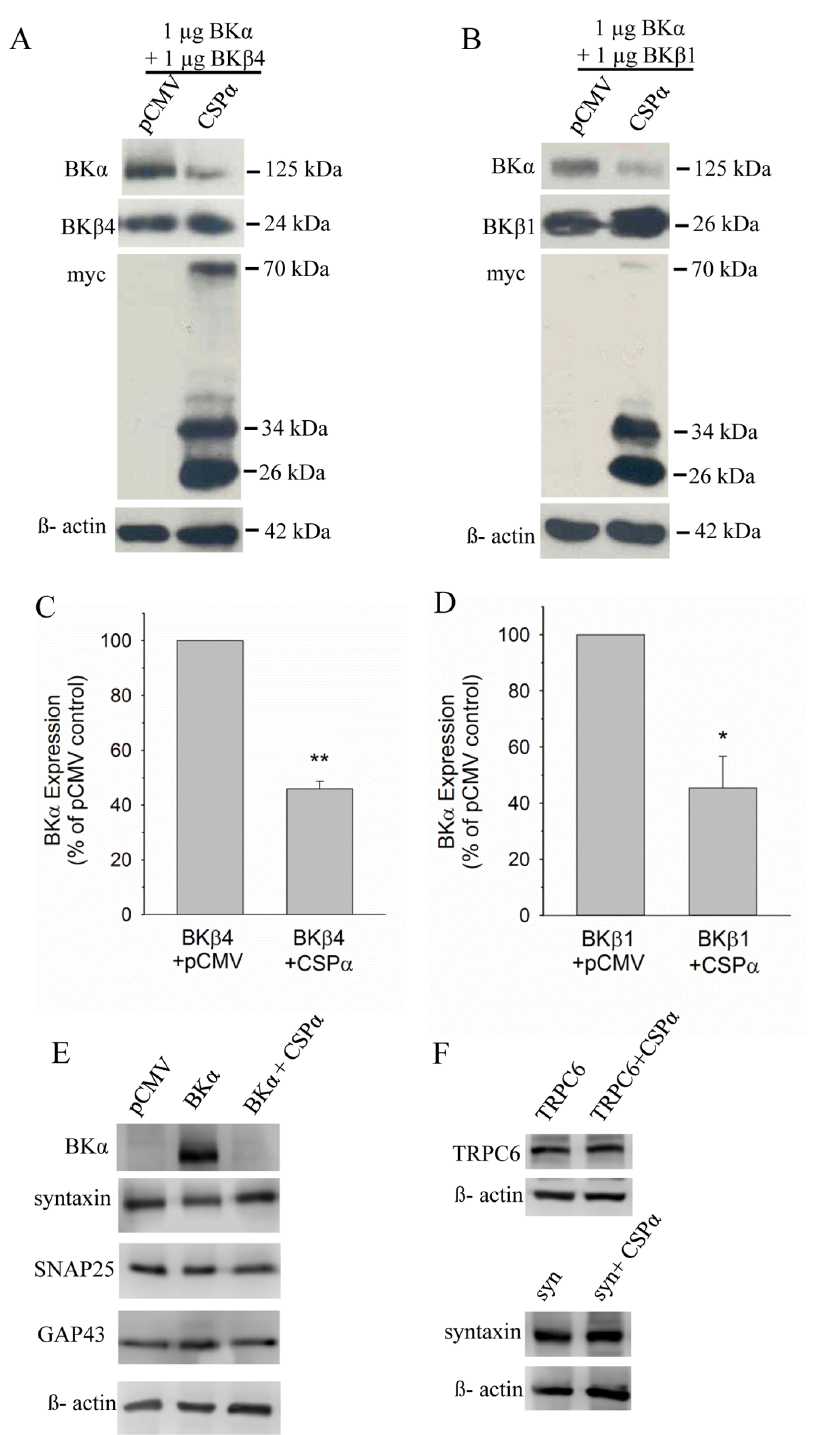
Figure 2. BK channel b -subunits (BK b 4 and BK b 1) do not alter the CSP a -mediated reduction in BK channel expression. CAD cells were transiently transfected with 1 m g BK a subunit cDNA plus 1 m g BK b 4 subunit cDNA ( A ) or 1 m g BK b 1 subunit cDNA ( B ), along with either 0.75 m g CSP a or pCMV vector (control). 24 h post-transfection, protein expression was analyzed by Western Blot with primary antibodies recognizing BK a subunit, BK b 4 subunit, BK b 1 subunit, myc epitope tag, and b -actin. C and D, Quantification of BK a subunit expression in CAD cells in the absence or presence of co-transfected CSP a , along with the presence of either BK b 4 (panel C) or BK b 1 (panel D). E CAD cells were transfected with cDNAs encoding pCMV vector alone, BK a subunit or BK a subunit + CSP a and the indicated proteins were evaluated by Western blot analysis. F CAD cells were transfected with TRPC6 channel or syntaxin1A cDNA in either the absence of presence of CSP a cDNA. Detection of b -actin was utilized to verify equal protein sample loading. Data are presented as mean 6 SE of 3 similar experiments; statistical significance was determined using one way ANOVA, *p , 0.05; **p , 0.01. Data shown in E and F are representive of 4 independent experiments.